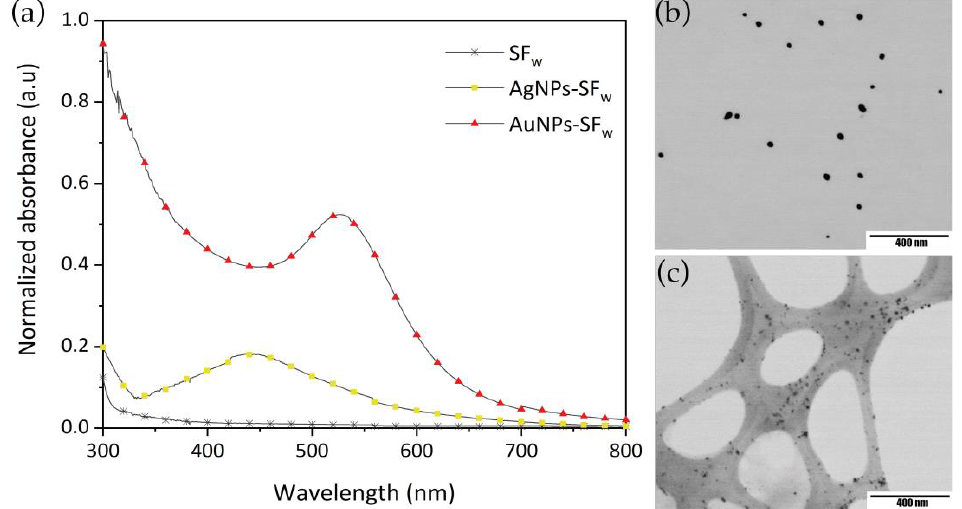
Figure 1. ( a ) Normalized UV-Vis absorption spectra of gold (line with red triangles) and silver (line with yellow squares) nanoparticles. STEM micrographs of ( b ) AuNPs-SF w and ( c ) AgNPs-SF w . Scale bar, 400 nm.